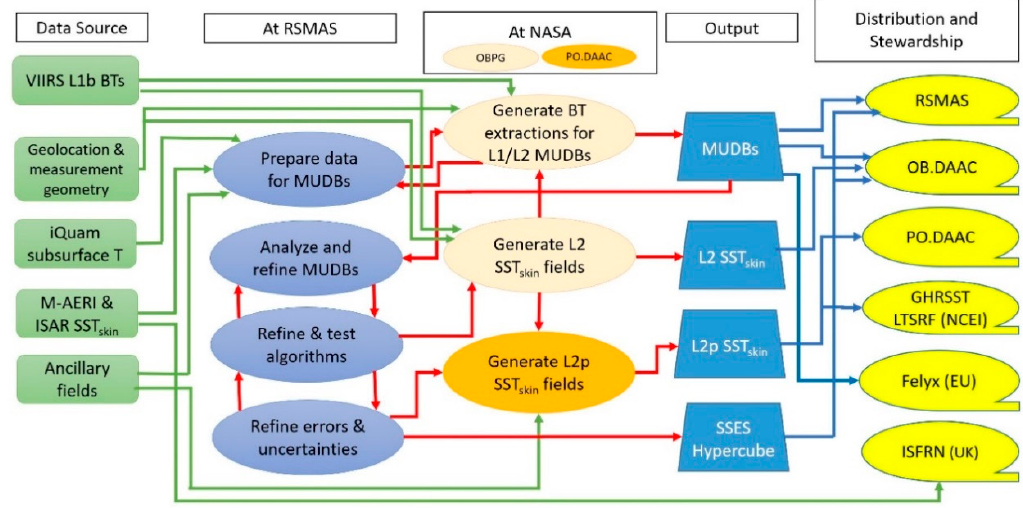
Figure 8. Flow chart showing the input data at left to the archive and distribution centers at right. The green lines indicate input data flow to operations and the blue lines the flow of derived variables to centers from where the data are accessible by the user community. Red lines show the flow of intermediate data, which is iterative when necessary. The acronyms are given in the list of acronyms at the end of the paper. Table 2. NASA definitions of processing levels.